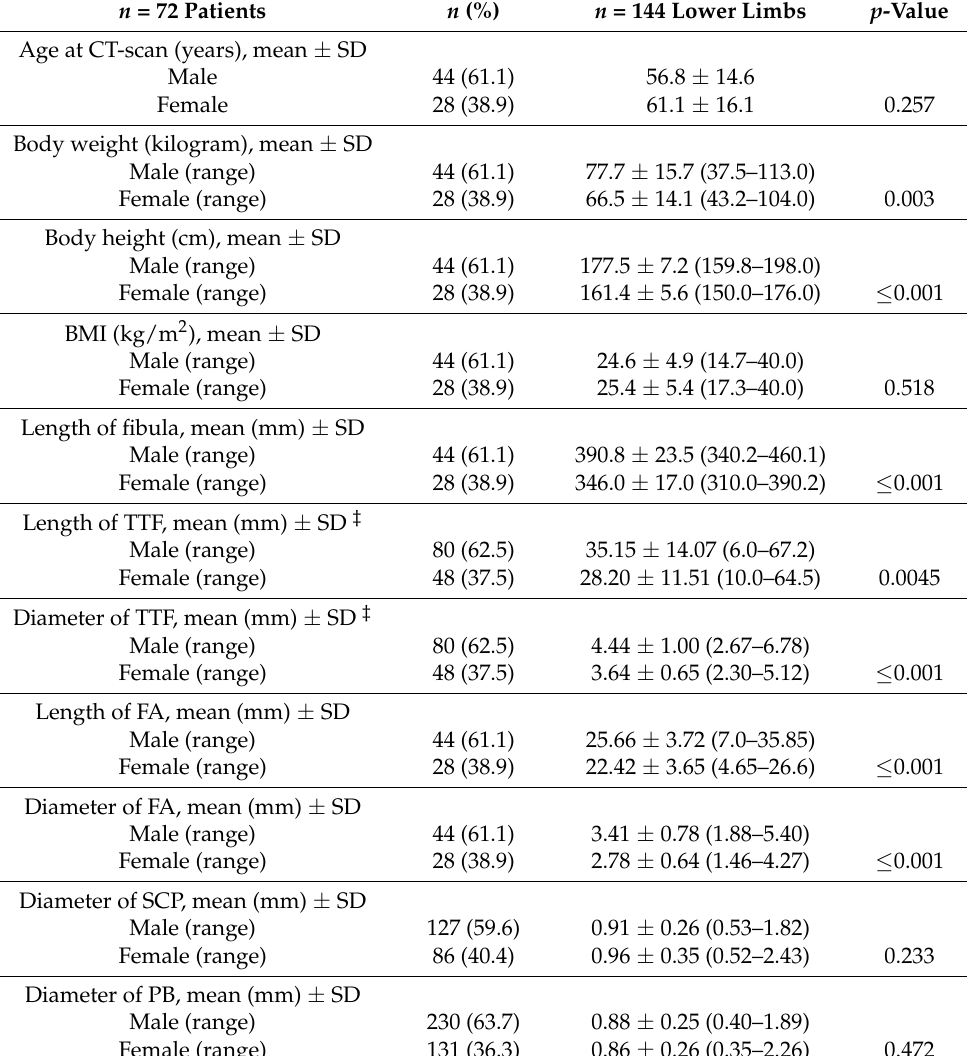
Table 1. CTA assessment for bone and vascular system parameters of the study group categorized for gender (cm, centimeter; FA, fibular artery; PB, periosteal branch; SCP, septo-cutaneous perforator; SD, standard deviation; TTF, truncus tibiofibularis). Annotation: ‡ Length and diameter of TTF were only assessed for type I-A branching